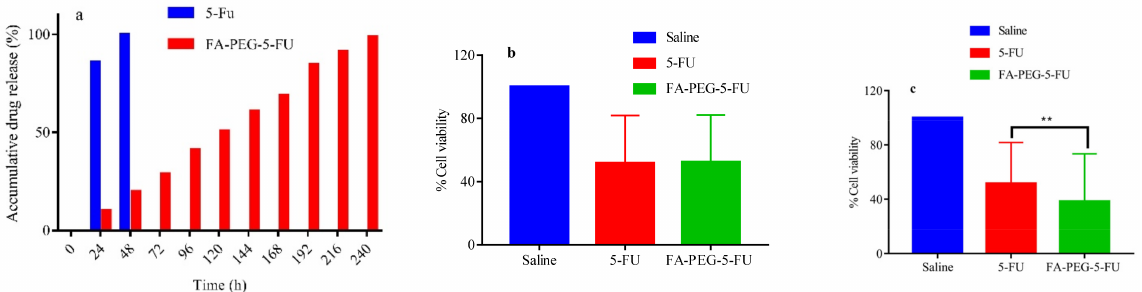
Figure 2. ( a ) Drug release profile, ( b ) in vitro cytotoxicity against Vero cells, ( c ) HeLa cells (significant difference at ** p < 0.005 5-FU vs.